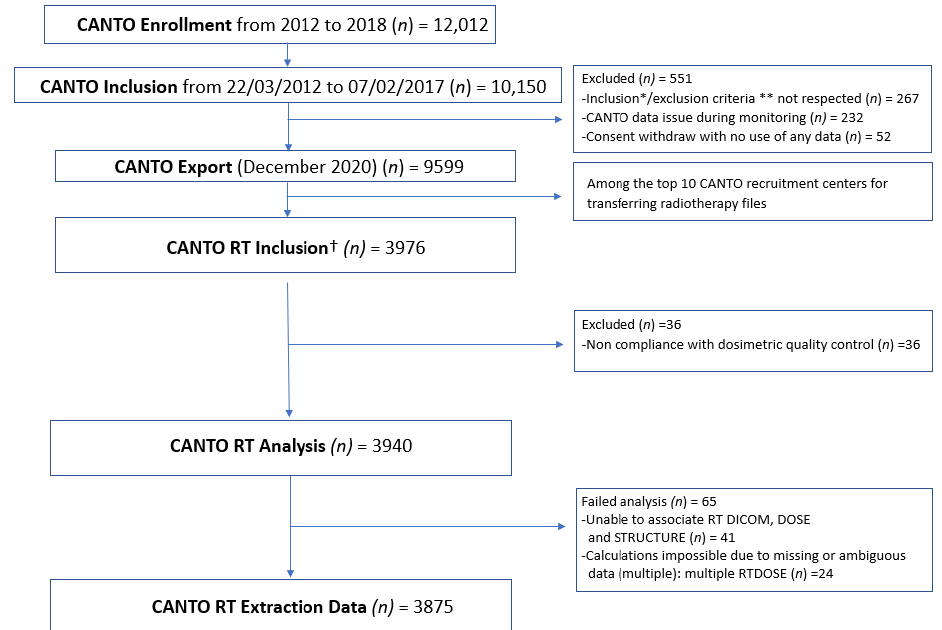
Figure 1. CANTO-RT Flowchart. RT: Radiation Therapy. * Inclusion criteria in CANTO: Female, 18 years of age and older, with infiltrating breast cancer diagnosed by cytology or histology, Tumor cT0-3, cN0-3, M0 before any treatment including surgery for breast cancer, patient fluent in French, free and informed consent for additional biological samples. † Inclusion criteria in CANTO RT: among the top 10 CANTO recruiting centers for transferring RT files to Aquilab, CT/RT in the same center + part of the selected centers, follow-up >3 years. ** Exclusion criteria in CANTO: Metastatic breast cancer; local recurrence of breast cancer; previous cancer within 5 years prior to cohort entry other than basal cell skin cancer or in situ cervical epithelioma; blood transfusion within the last 6 months; persons deprived of liberty or under guardianship (including curatorship).